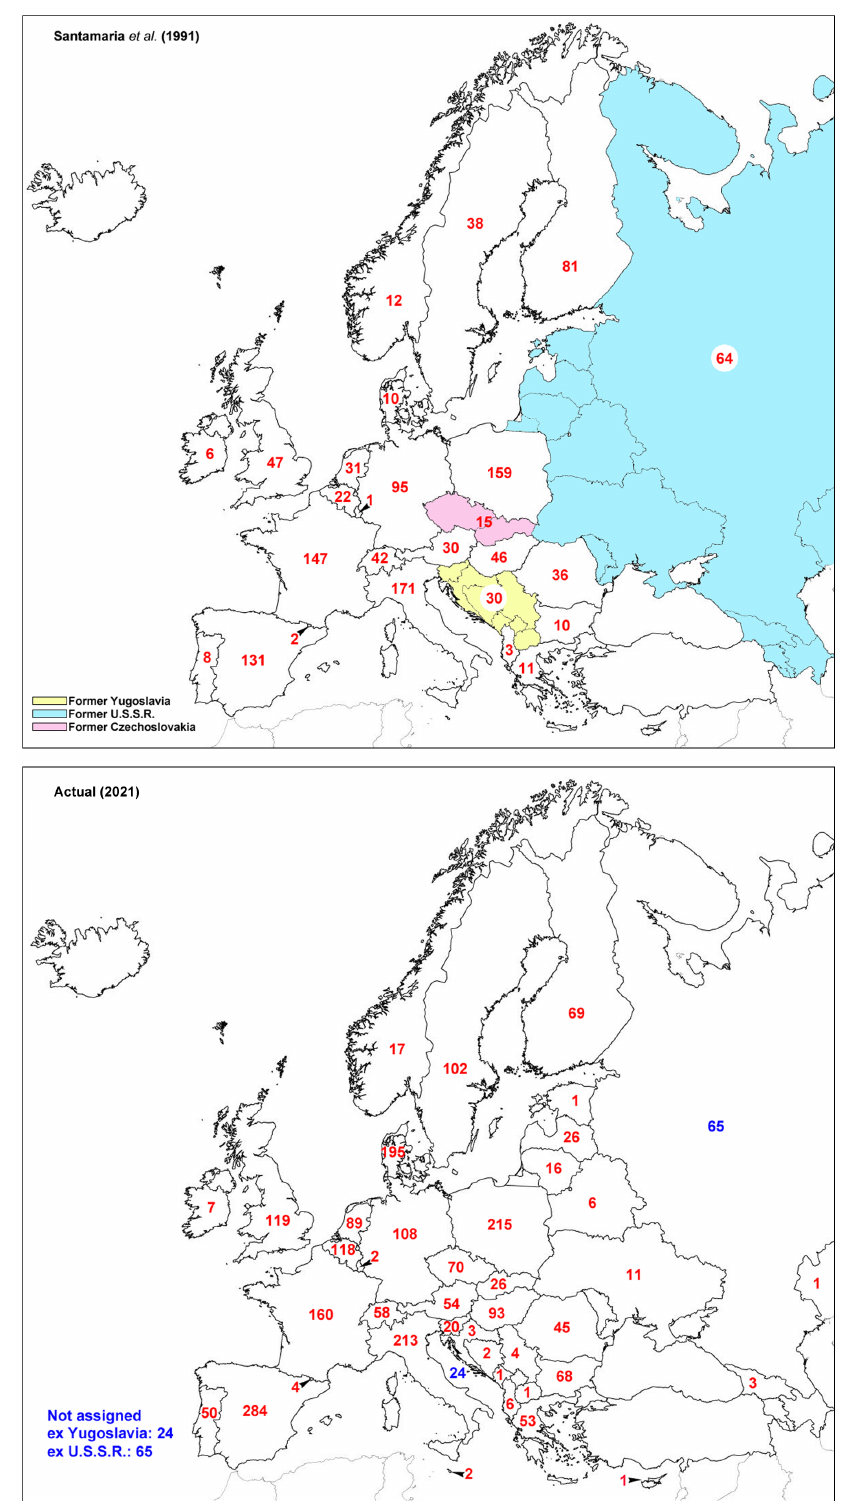
Fig. 95. Political maps of Europe showing the number of species of Laboulbeniomycetes at the moment of the European check-list published in 1991 by Santamaria et al. (top), and according to current data